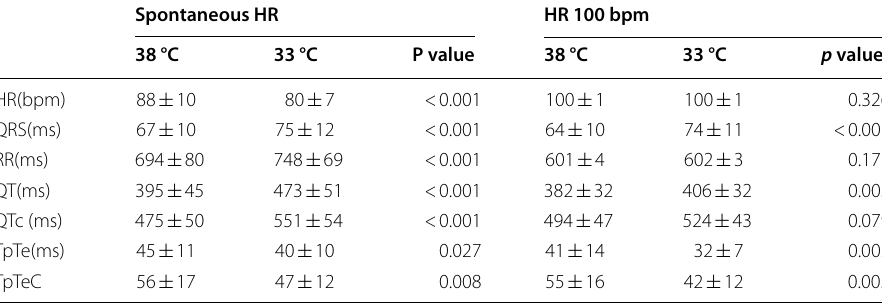
Table 2 Electrocardiographic